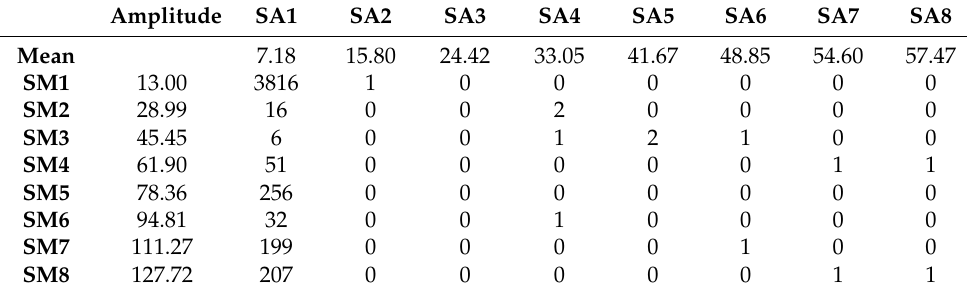
For the time domain extrapolation based on LSTM model, the trained model of 25 groups of original extrusion cycle data can be directly predicted. This method does not need artificial calculation of multiple links, and the load data about time series can be obtained. The predicted data and real data of five groups of extrusion cycles are counted by rain flow counting method. The eight-level load spectra are shown in Tables 4 and 5, respectively. Table 4. Load spectrum compiled based on LSTM forecast data.